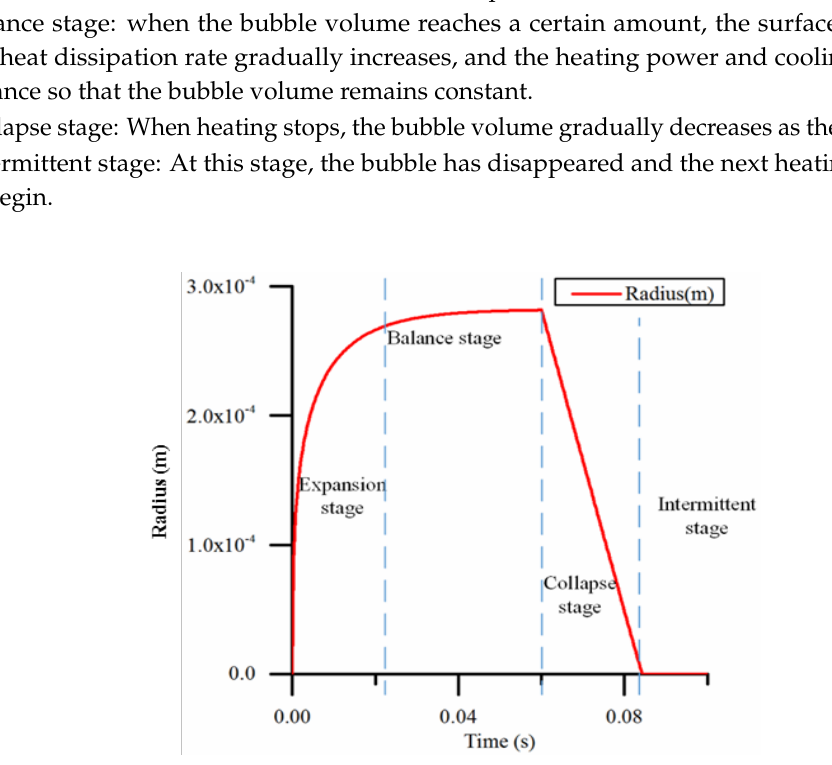
Figure 11. The bubble volume calculated by the model when the duty cycle is 60% and the heating frequency is 100 Hz. In addition, when the heating power is relatively high, the volume of the pump chamber determines the maximum volume of the bubble. In the case of low heating power, heating power and heat dissipation determine the size of the bubble. Based on the rules above, we can see that for a defined pump chamber volume and heating frequency there will be a suitable duty cycle to achieve maximum flow. With high frequency, a lower duty cycle is needed to achieve a greater working flow due to the short intermittent heating period and subsequent short heat dissipation time. We also calculated and verified the working results of micro-pump at different frequencies, as shown in Figure 12. The results show that the model can predict the working effect of micro-pump at most frequencies, especially with high duty cycles, such as 50–70%. However, when the duty cycle is small, the model does not appear to be very accurate. The inaccuracy is mainly the result of not considering the nucleation process in this model. Former studies have shown that the liquid should be heated over the boiling point to generate a bubble. When the temperature of the liquid has already reached the vaporization temperature, the surface tension has a very large pressure on the gas when the bubble radius is very small, and tiny bubbles soon disappear. A very short heating time is insufficient to produce bubbles, and it is even insufficient to